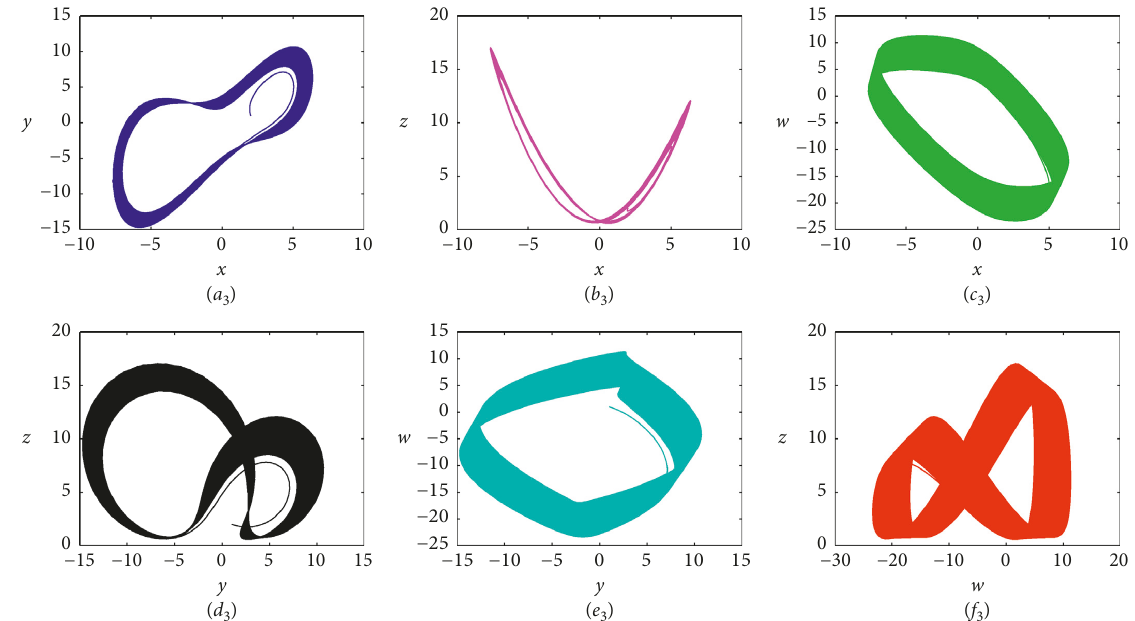
Figure 8: Phase portraits of Experiment 1 with a � 2 , b � 3 , t � 1000: ( a y − z plane; ( e